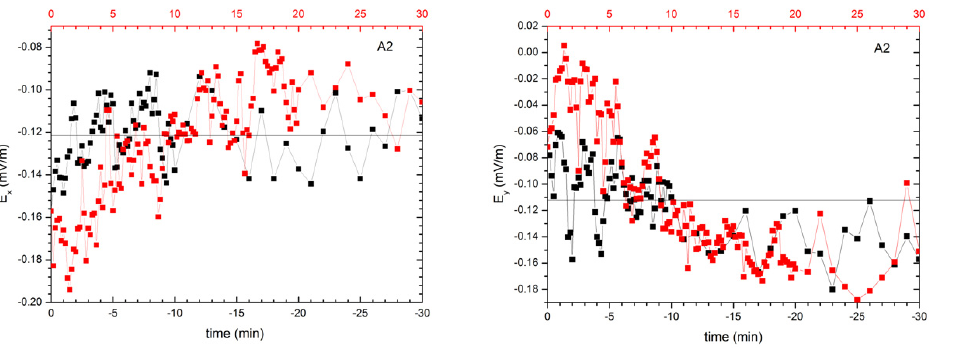
and E (in mV/m), observed along the AB and AC dipoles, respectively, related to the shot in Figure 2 . Natural electric field components, E x y A2. Black symbols are used for data measured 30 min before the shot, while red symbols are used for data registered 30 min after the shot. The zero time of both the black and red scales corresponds to the shot time. The black continuous line represents the average value of the field component before the shot.